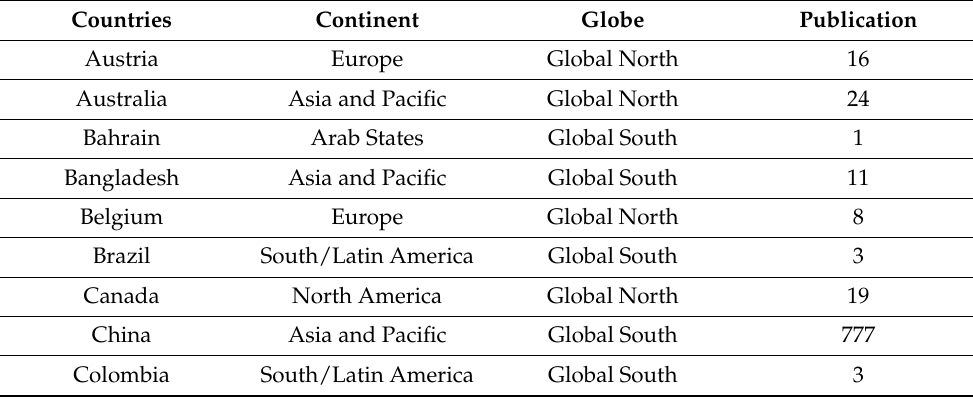
Table A1. Frequency of published documents across the